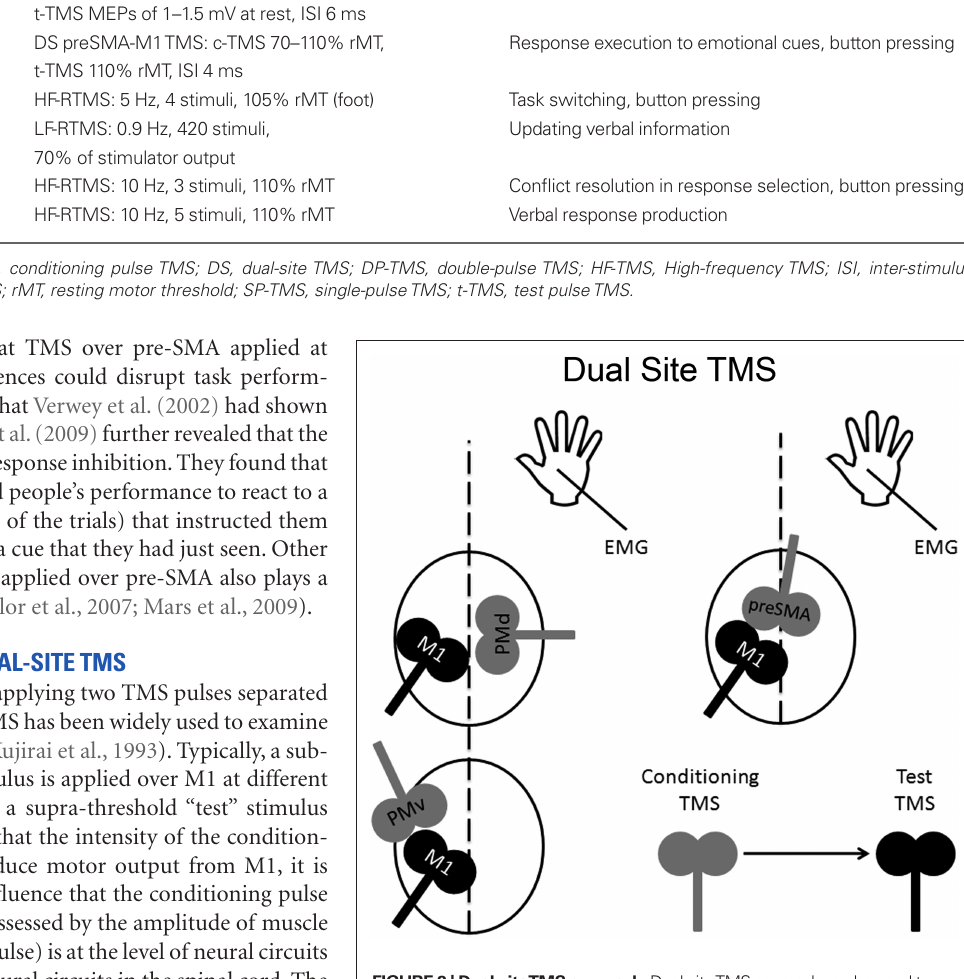
Figure 2 | Dual-site TMS approach. Dual-site TMS approach can be used to examine the time course of interactions in a particular neural circuit containing a non-primary motor area and M1. The idea is to stimulate a non-primary motor area with a conditioning pulse to examine its effect on a subsequent supra-threshold test pulse to M1. Changes in M1 can be inferred by measuring any possible changes in its motor excitability on a hand muscle using